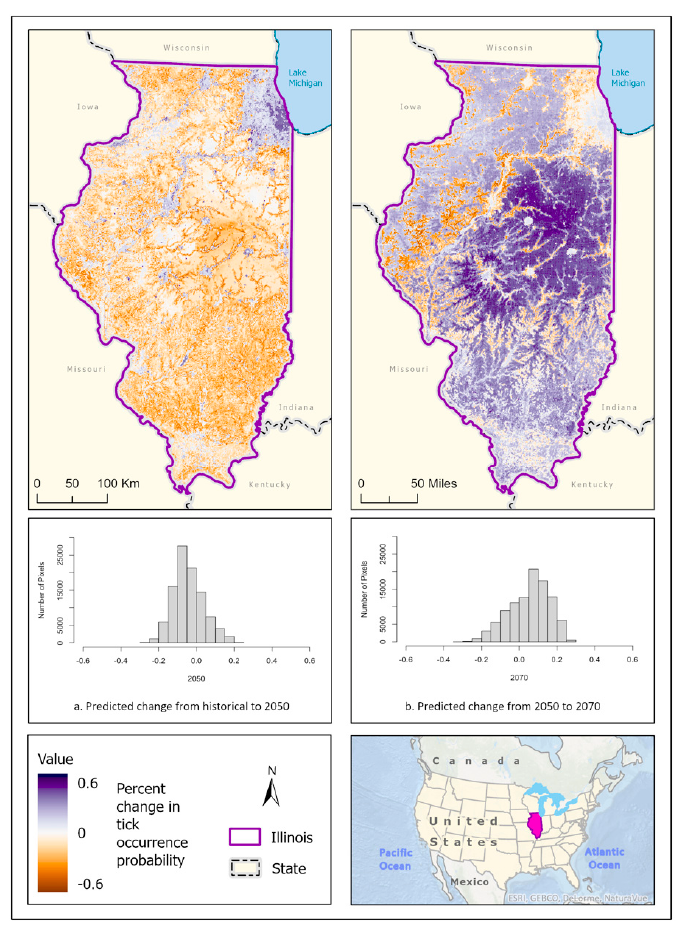
Figure 9. Percent change in the likelihood of A. maculatum occurrence between the historical climate and 2050 ( left ) and from 2050 to 2070 ( right ). Red shades indicate a reduced likelihood of occurrence (negative change), and blue shades indicate an increased likelihood of occurrence (positive change). The histograms represent the number of pixels (y − axis) containing the binned percentage likelihood (x − axis) of A. maculatum suitable habitat across the map. Inset map indicates the location of Illinois within the United States/North America.